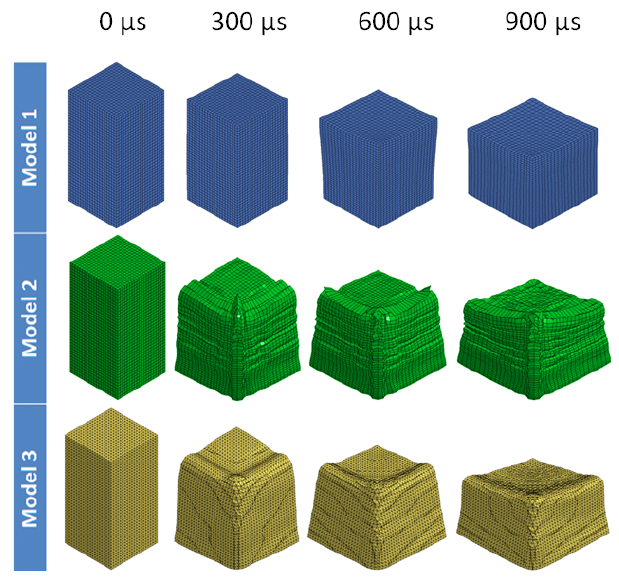
Figure 5. Deformation of the homogenized foam model.